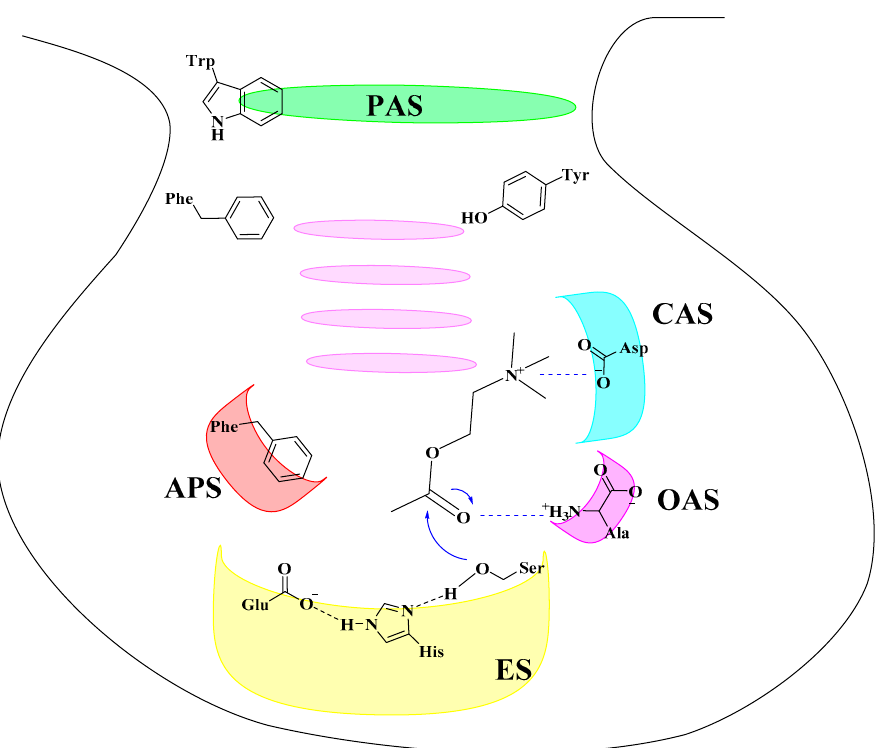
Figure 9. Active site of AChE [4] (ES: Estearic site, PAS: Peripheral Anionic Site, CAS: Catalytic Anionic Site, OAS: Oxianion Pocket, APS: Acyl Pocket Site, Ser: Serine, His: Histidine, Glu: Glutamate, Phe: Phenylalanine, Asp: Aspartate, Ala: Alanine, Trp: Tryptophan, Tyr: Tyrosine) Reproduced with permission.